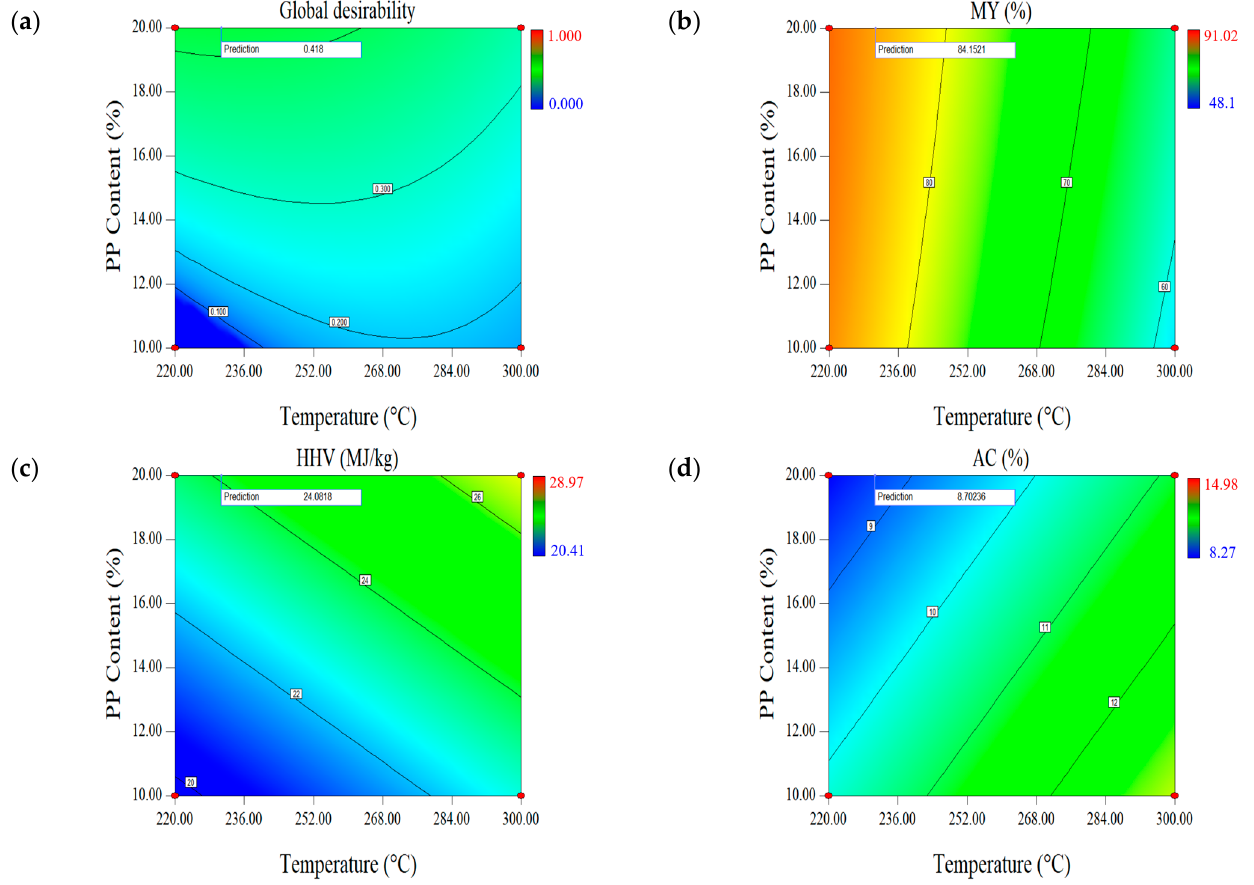
Figure 2. Contour plots for global desirability and the MY-HHV-AC response set: ( a ) Global desir- ability, ( b ) mass yield (MY), ( c ) higher heat value (HHV), and ( d ) ash content (AC).